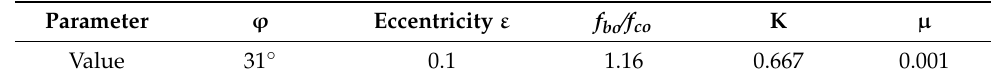
Figure 13. Stress ‐ strain relationships for concrete [16]. ( a ) Compressive stress ‐ strain curve; ( b ) Ten ‐ Figure 13. Stress-strain relationships for concrete [16]. ( a ) Compressive stress-strain curve; ( b ) Tensile sile stress ‐ strain curve. stress-strain curve. Table 8. Input parameters for the CDP Table 8. Input parameters for the CDP model.